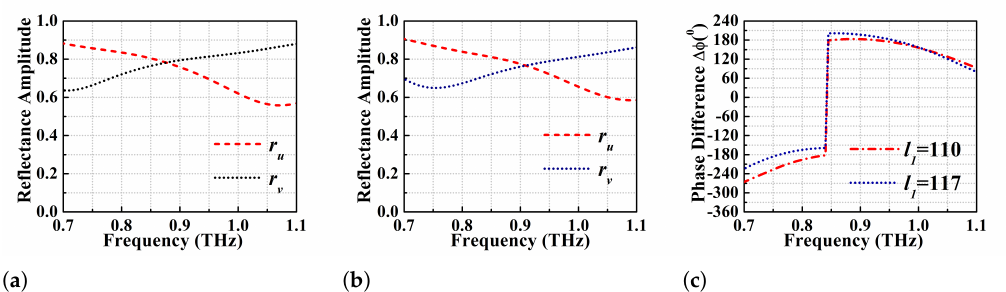
Figure 6. Magnitude of the orthogonal reflection coefficients r u and r v for ( a ) l 1 = 117 µ m, ( b ) l 1 = 110 µ m, ( c ) the phase difference between r u and r v in the PCR defined